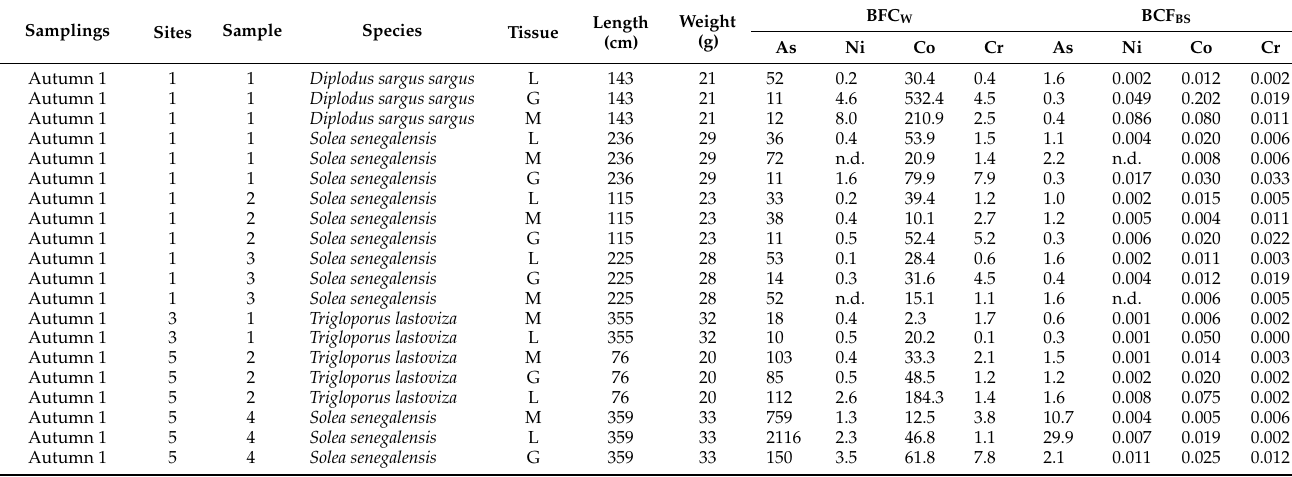
Table A1. Biometric characteristics of fish found in Algeciaras Bay and Bioconcentration factors from water and bottom sediments (n.d.: non detected; L: liver; M: muscle; G: gills).n.d.: non detected; L: liver; M: muscle; G: gills.